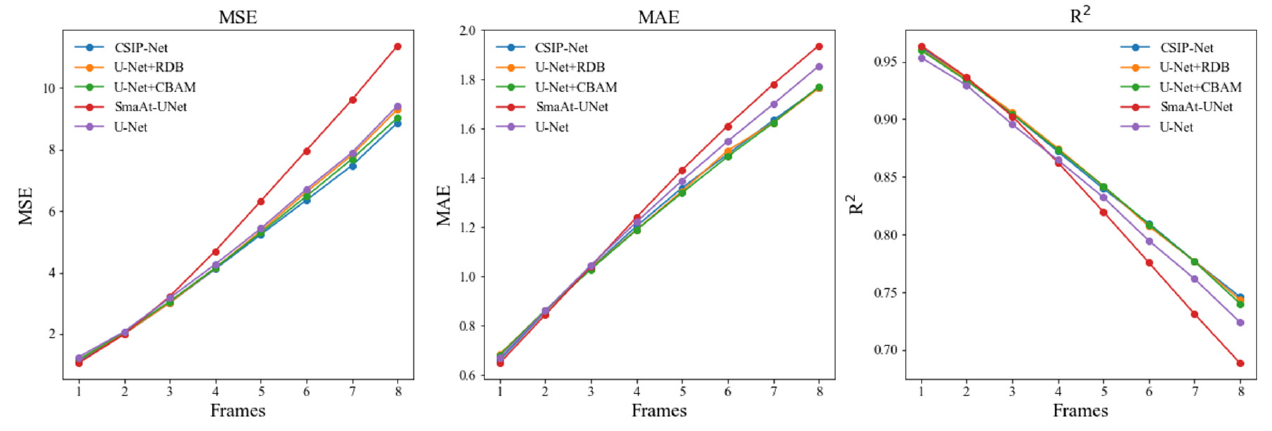
Figure 8. Model prediction performance evaluation results.